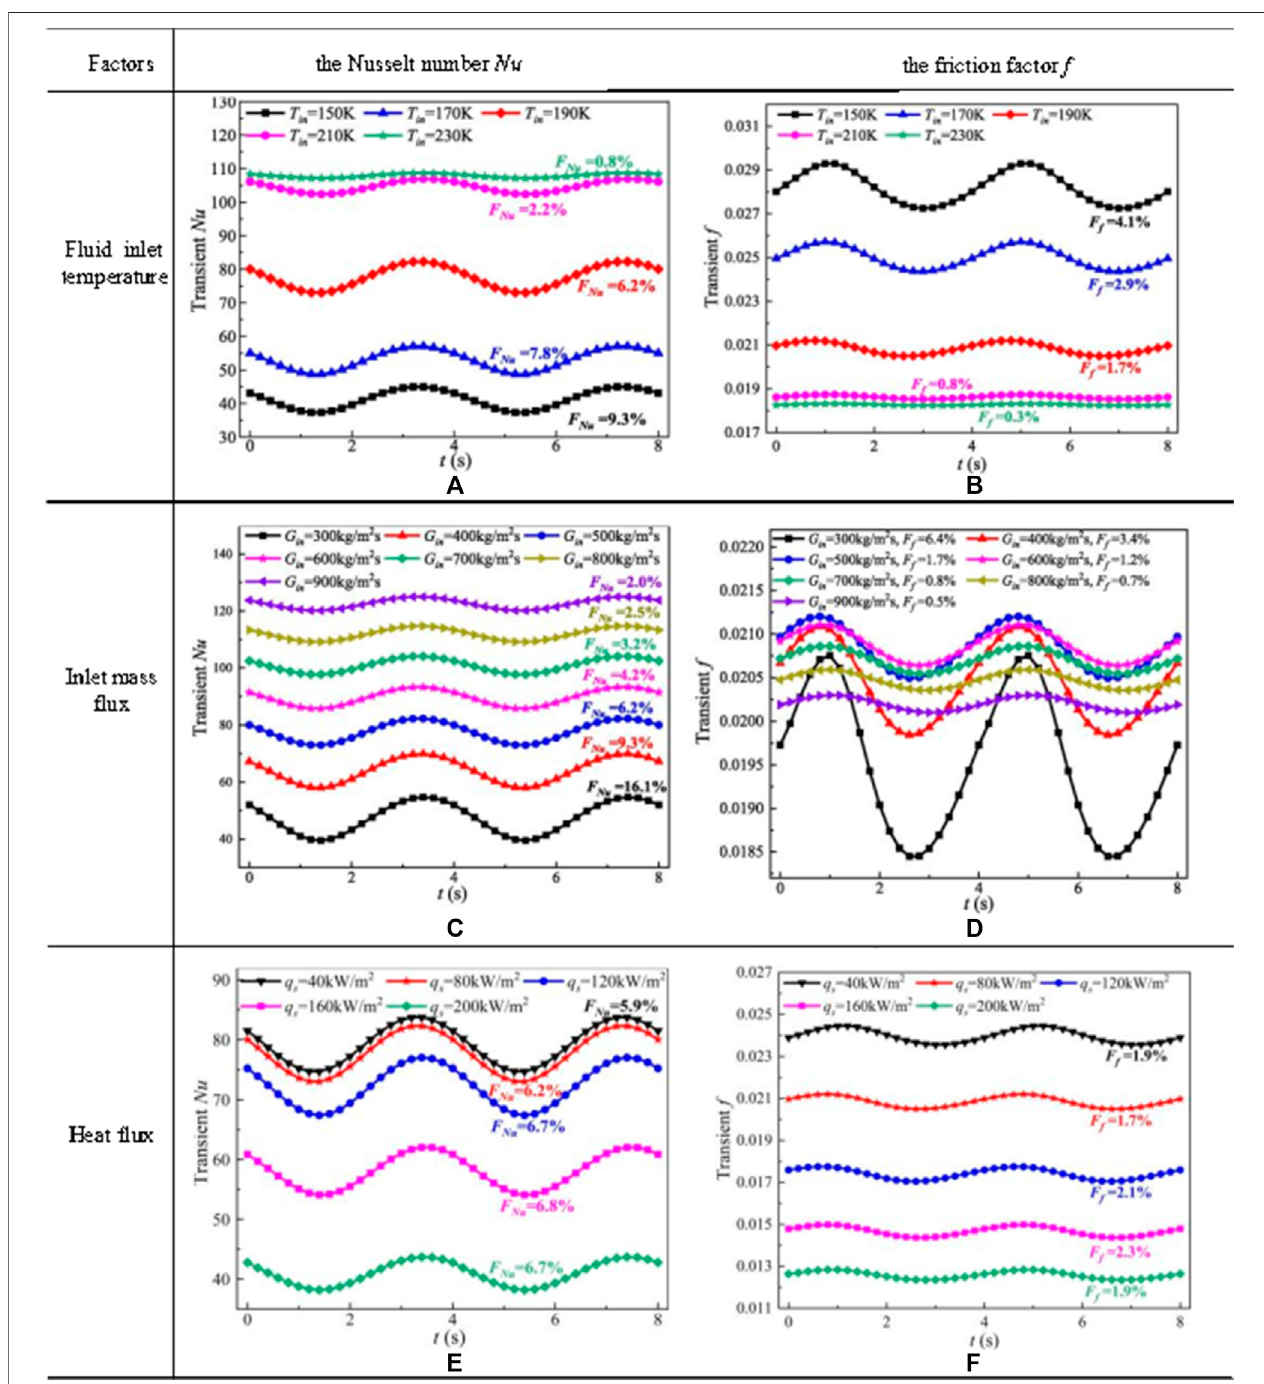
FIGURE 5 | Effect of operating conditions on thermal and hydraulic performance (Chen et al., 2022).